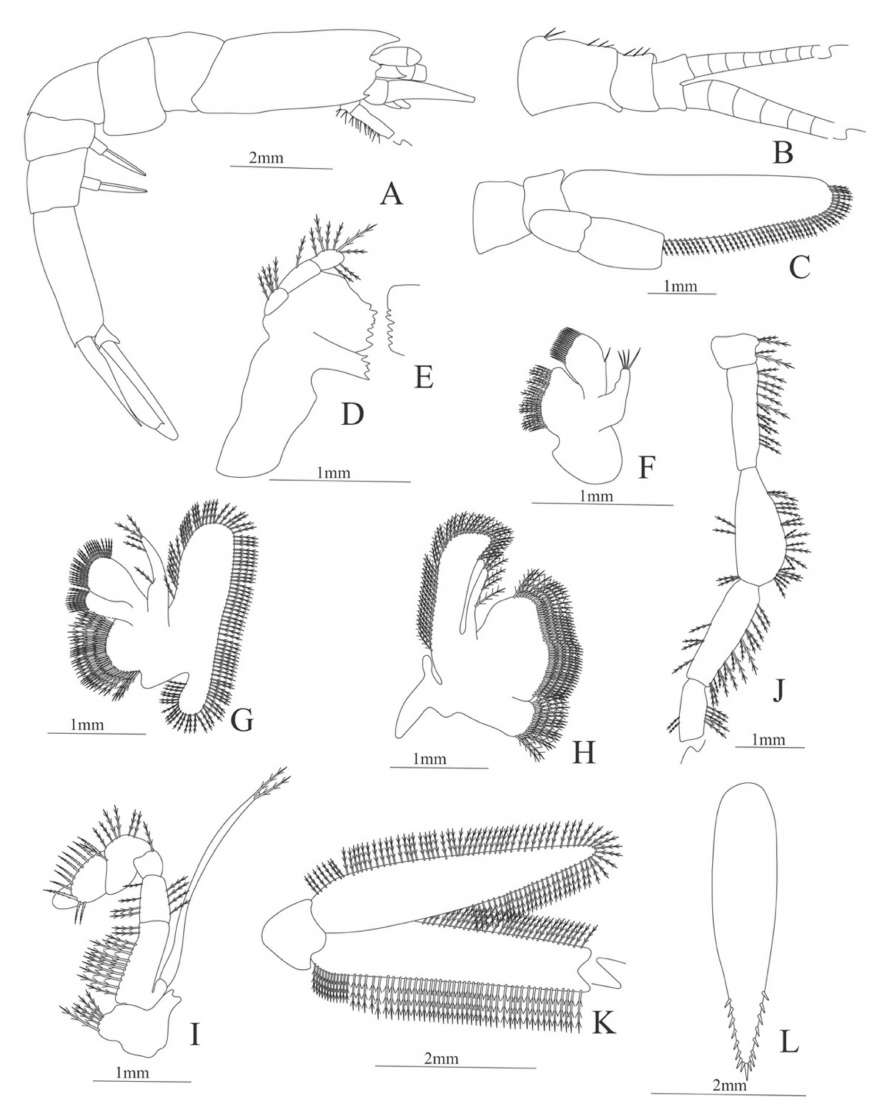
Figure 7. Ephyrina ombango : ( A ) lateral view; ( B ) antennule; ( C ) antenna; ( D ) left mandible; (E) right mandible (cutting edge); ( F ) maxillule; ( G ) maxilla; ( H ) first maxilliped; ( I ) second maxilliped; ( J ) third maxilliped; ( K ) uropods; ( L )